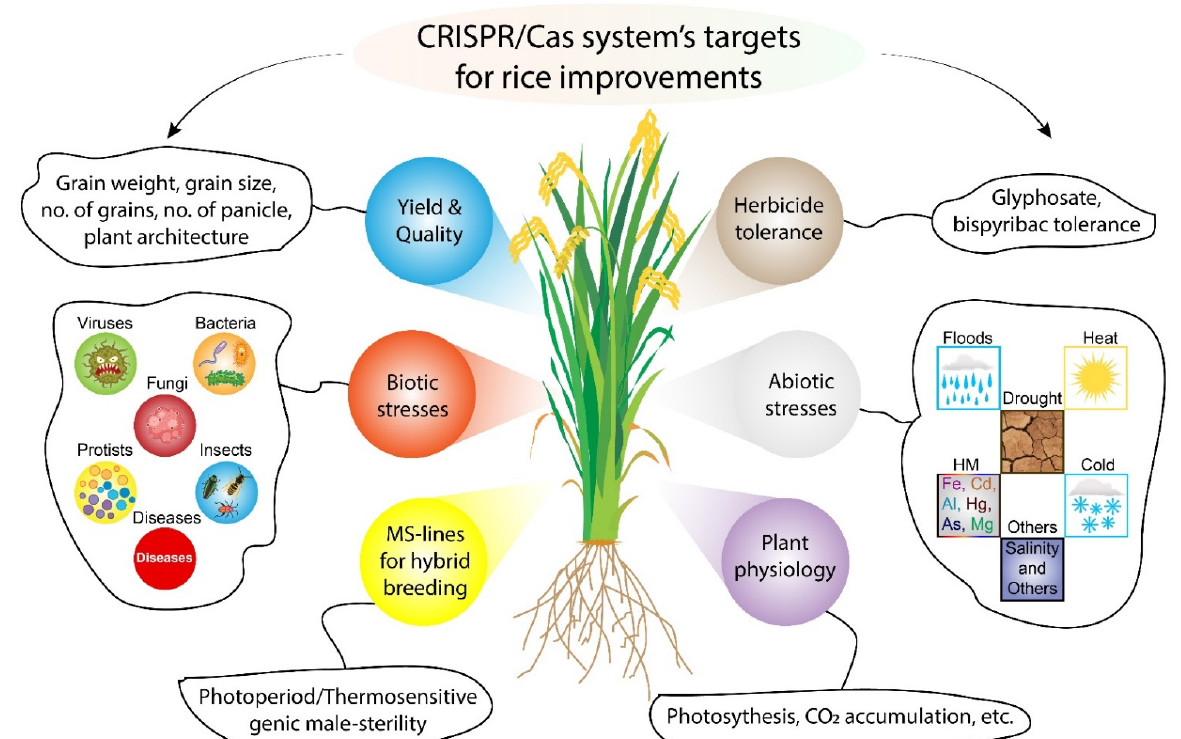
Figure 3. Potential targets of CRISPR/Cas systems for rice crop improvement. Rice can be improved by targeting any potential negative regulator of yield, quality, biotic and abiotic stress tolerance, and plant physiology. Male sterile (MS) lines can be developed for hybrid development by targeting potential genes such as Thermo - sensitive Male Sterility 5 gene. HM, Heavy Metal; Fe, Iron, Cd, Cadmium; Al, Aluminum; Hg, Mercury; As, Arsenic; Mg, Magnesium.